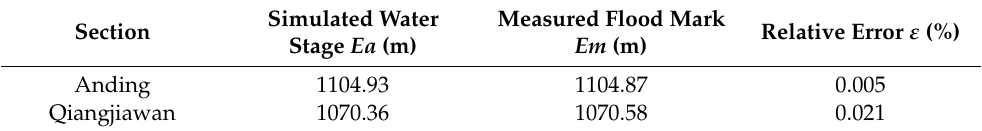
Table 5. Relative error between the simulated and measured water